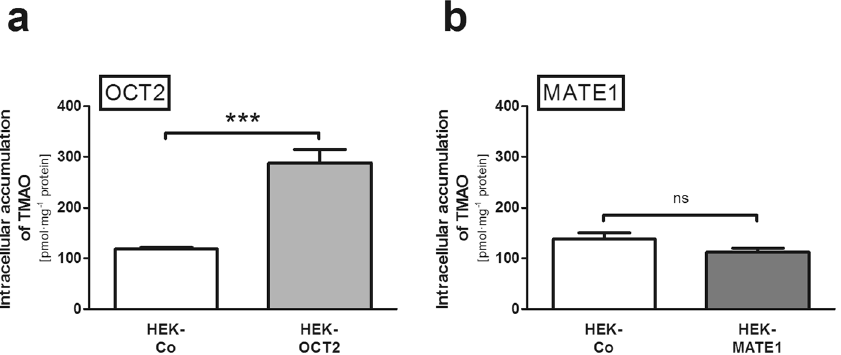
Figure 1. Intracellular accumulation of TMAO (10 µ M) by HEK cells expressing OCT2 (HEK-OCT2) ( a ) or MATE1 (HEK-MATE1) ( b ) and the respective control cells (HEK-Co) after 2 min. Data points are 4 × n = 2 for OCT2 and 2 × n = 2 for MATE1, mean ± SEM, *** p < 0.001 vs.